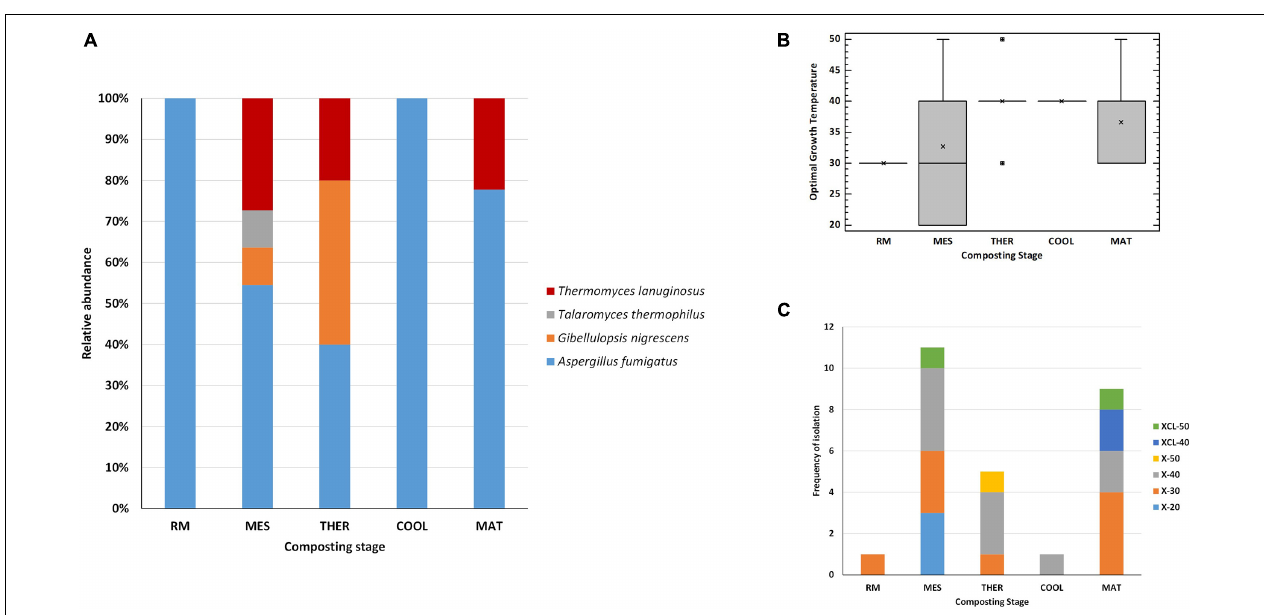
FIGURE 5 | Thermophilic lignocellulolytic fungal strains at the different stages of composting. (A) Relative abundance of the species; (B) box-and-whisker plot summarizing range of optimal growth temperature for the different fungal strains; mean values (x), median (I), and outliers ( (cid:3) ) are represented; (C) frequency of isolation of the phenotypes: xylanolytic strains with optimal growth at 20 ◦ C (X-20), 30 ◦ C (X-30), 40 ◦ C (X-40), and 50 ◦ C (X-50), and xylanolytic-cellulolytic-ligninolytic strains with optimal growth at 40 ◦ C (XCL-40) and 50 ◦ C (XCL-50). Composting stage: RM, raw material; MES, mesophilic; THER, thermophilic; COOL, cooling; FP, final composting